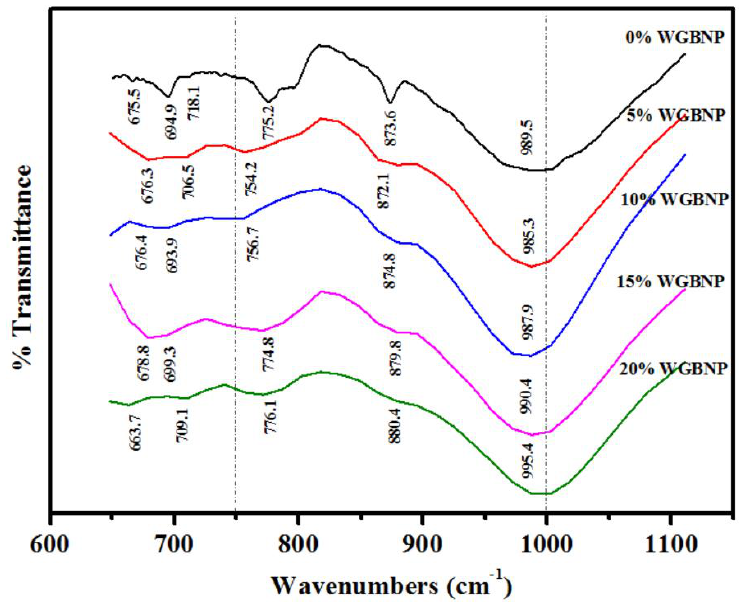
ff erent amounts of